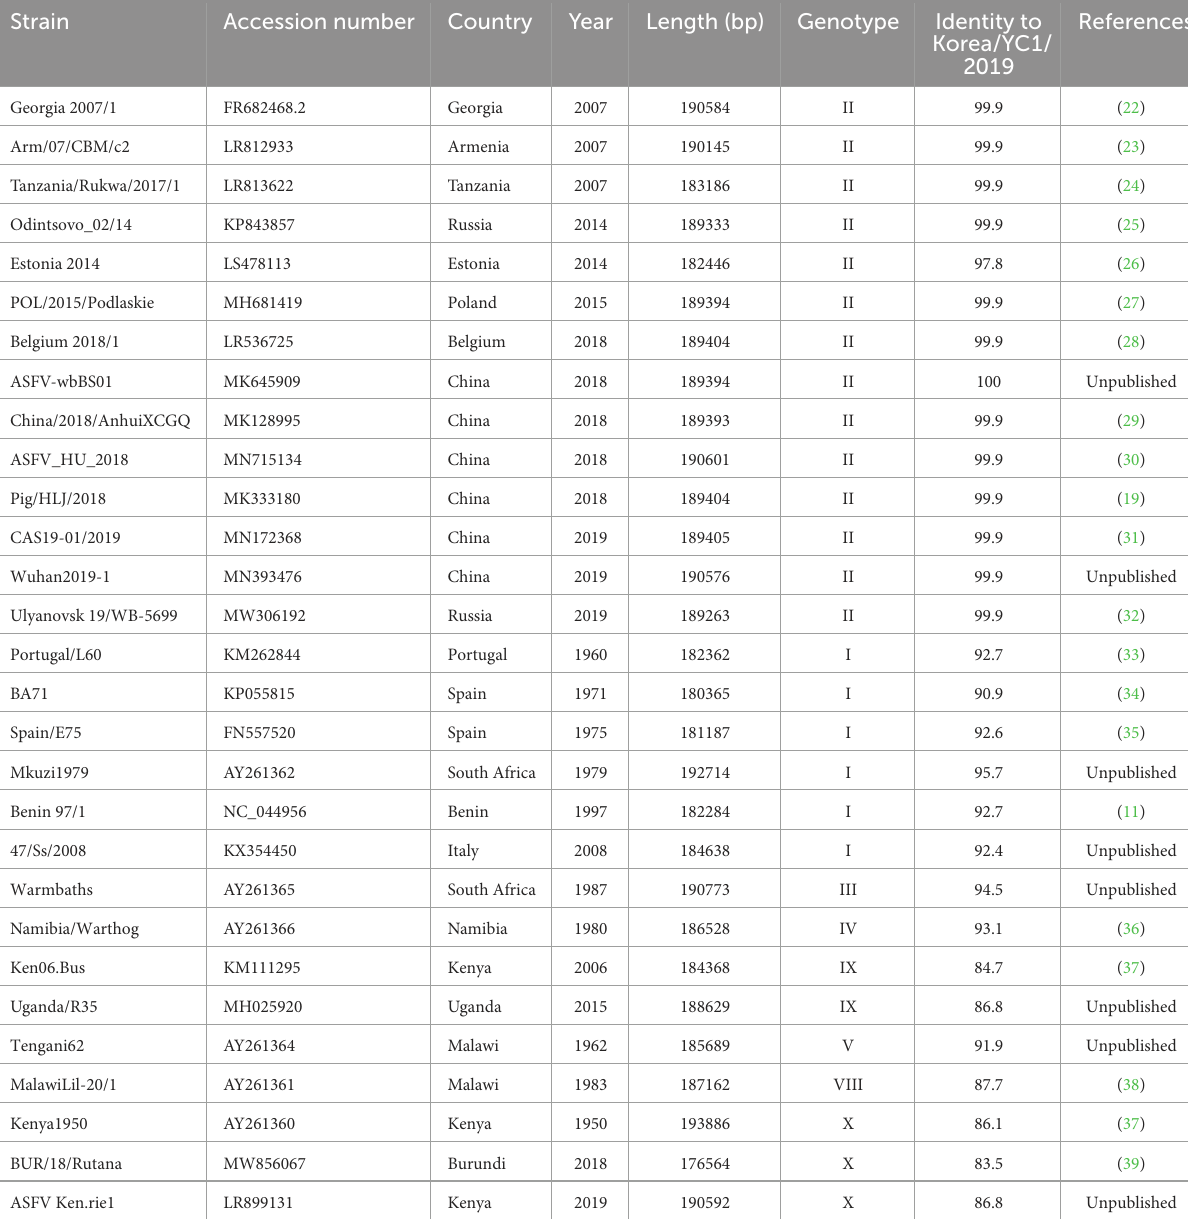
TABLE 2 Comparison of genome features of different ASFV strains and